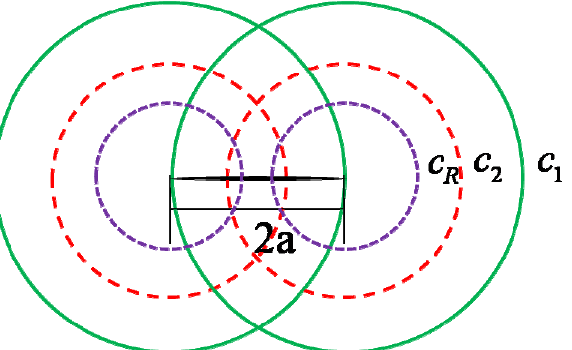
Figure 3. Wave fronts emanating from crack